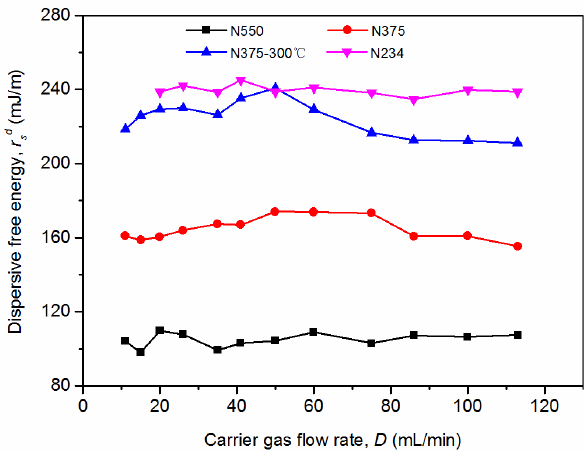
Figure 9: Dispersive free energy of different samples versus carrier gas flow